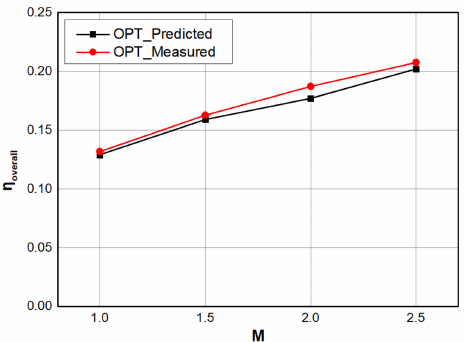
Figure 15. Overall averaged FCE for optimized hole.